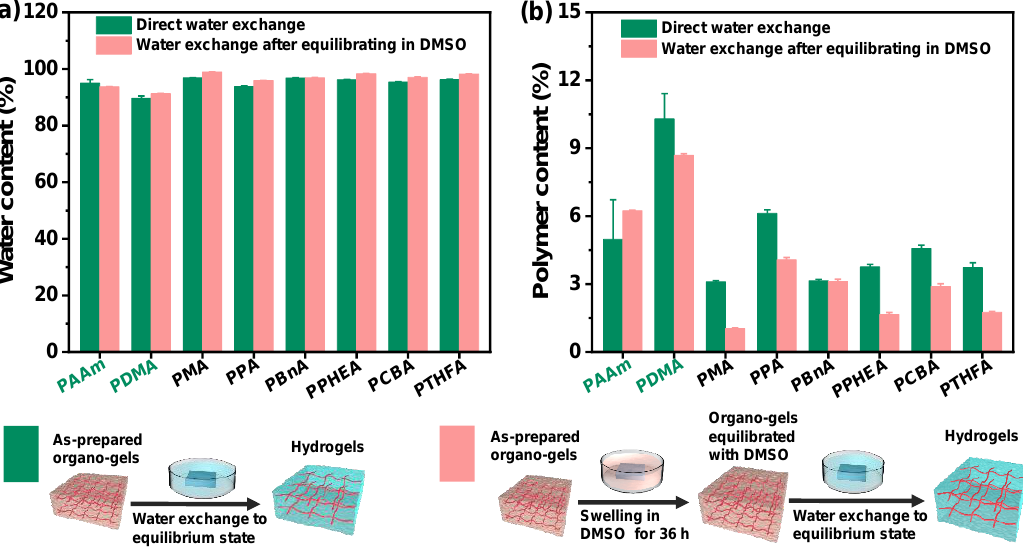
Figure 2. The water content and polymer content of the hydrogels with the different chemical structures obtained by two different routines of the direct solvent exchange of the as-prepared organo- gels after polymerization and the solvent exchange of organo-gels with equilibrium state in DMSO, respectively: ( a ) the water content of hydrogels; ( b ) the polymer content of hydrogels.